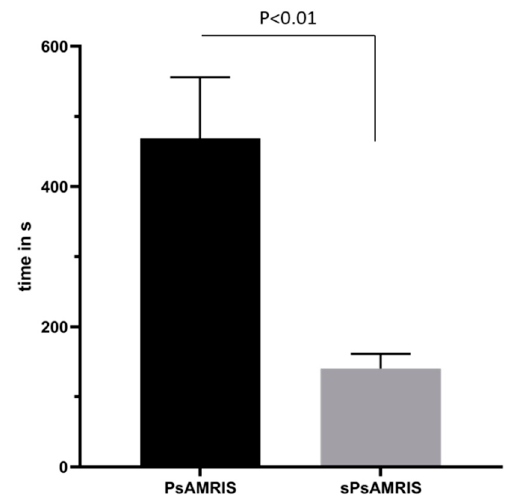
Figure 3. Mean time burden for completion of scoring based on PsAMRIS and sPsAMRIS per MRI study. Scoring on the basis of sPsAMRIS was completed in significantly less time than scoring on the basis of PsAMRIS ( p < 0.01).